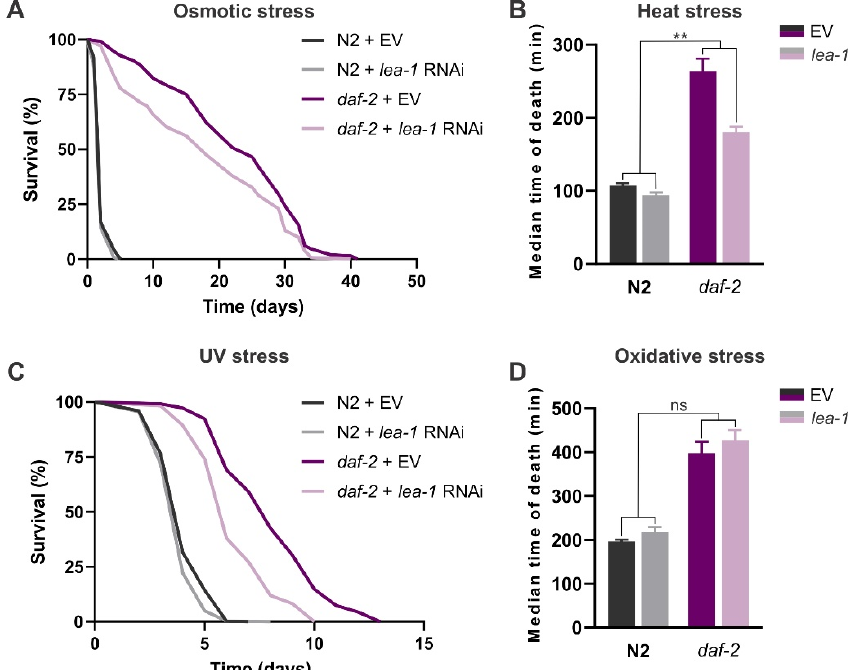
Figure 6. The role of lea-1 in worm stress resistance: wild-type N2 and daf-2(e1370) mutants with lea-1 knockdown subjected to ( A ) osmotic stress, 500 mM NaCl; ( B ) heat stress, 40 °C; ( C ) UV stress (254 nm, 200 J/m 2 ), and ( D ) oxidative stress, 0.28% tert-butyl hydroperoxide (TBHP). Survival curves in ( A , C ) represent pooled data from two and three independent experiments, respectively. Error bars in ( B , D ) indicate SEM of three independent trials. Survival data of all the stress assays are summa-rized in Tables S3–S6. EV—empty vector control. ns: p > 0.05, ** p ≤ 0.01 (RNAi*strain interaction,